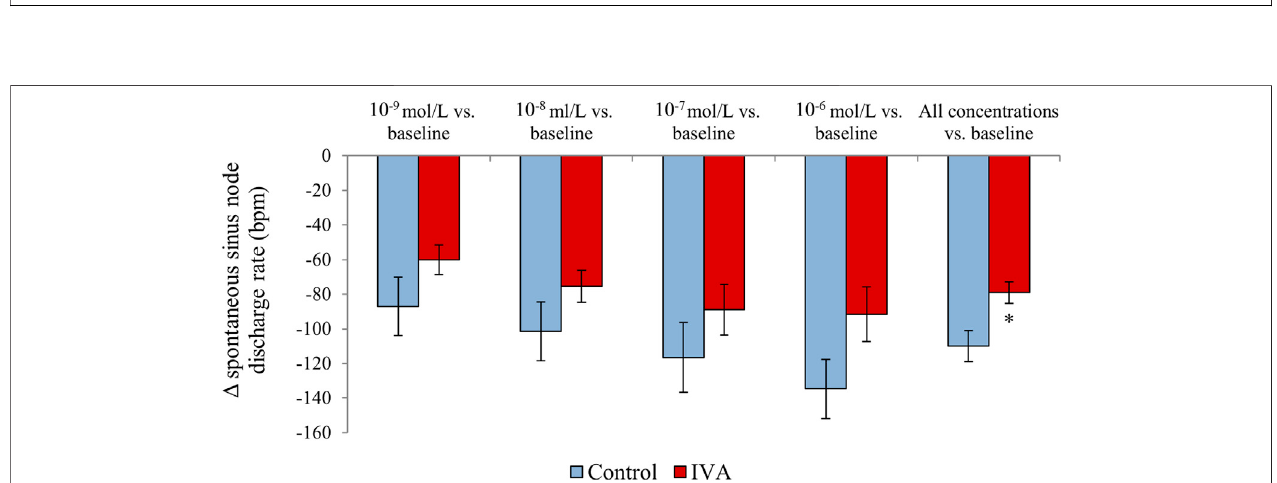
FIGURE 6 | Systolic blood pressure changes during vagus nerve stimulation at 2, 5, 10, and 20 Hz compared with the baseline values in the ivabradine-treated (IVA; n (cid:2) 10)andnon-treated(Control; n (cid:2) 6)rats.Dataareexpressedasmeans ± standarderrorofthemean.* p < 0.05forIVAvs.ControlratsusingthepairedStudent ’ s t -test or the Mann-Whitney U test, as appropriate.